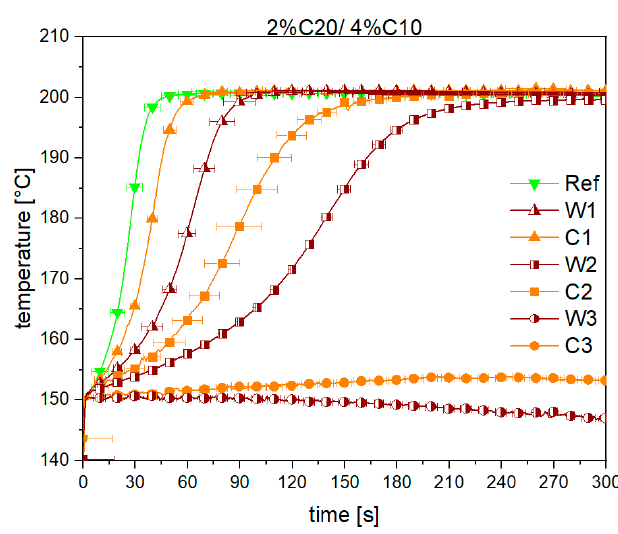
Figure 7. Compensation series (equimolar) of formulation 3 (2% C20, 4% C10). Polymerized at T pol = 150 °C and T mold = 150 °C.